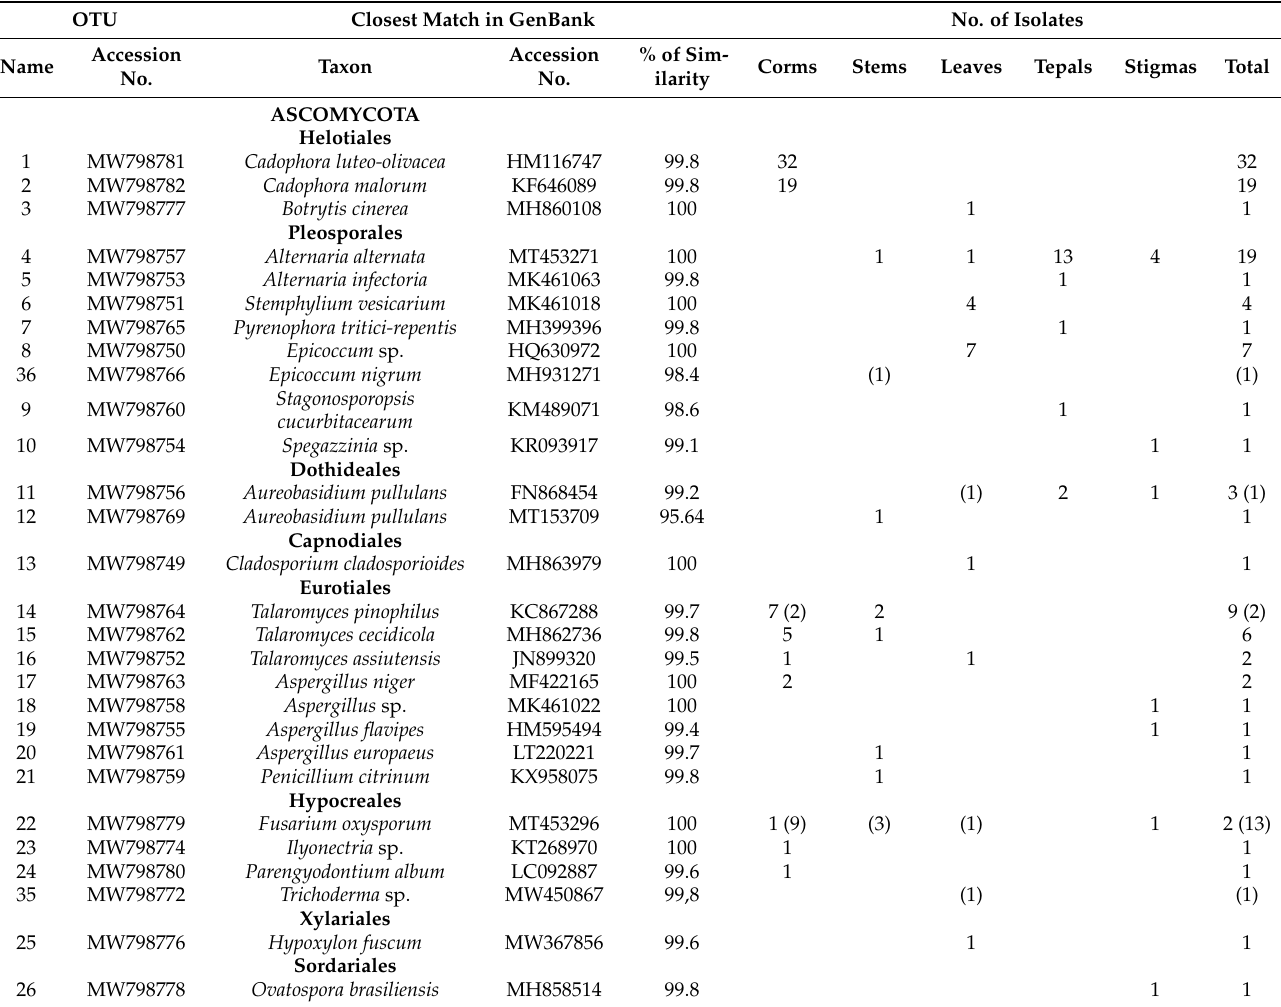
Table 2. Description of the OTUs representing the fungal endophytes and pathogens isolated from different tissues of Crocus sativus . OTU Closest Match in GenBank No. of